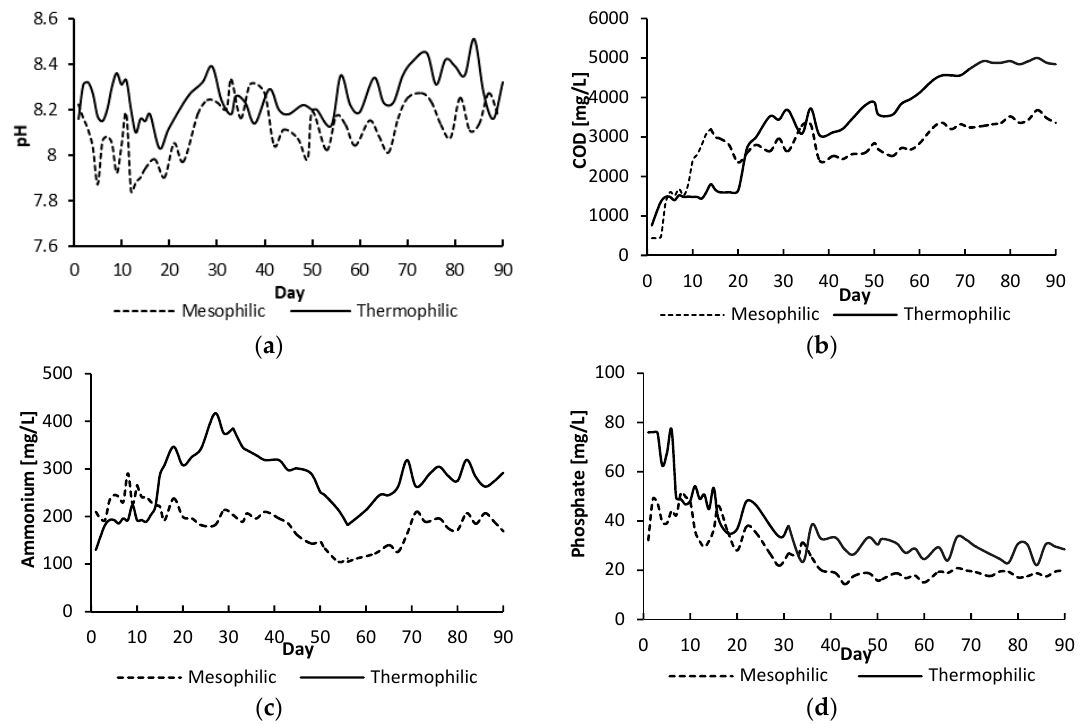
Figure 6. Changes of pH ( a ), dissolved organic matter (COD) ( b ), ammonium nitrogen ( c ) and orthophosphates ( d ) during the anaerobic digestion of ORF after autoclaving.